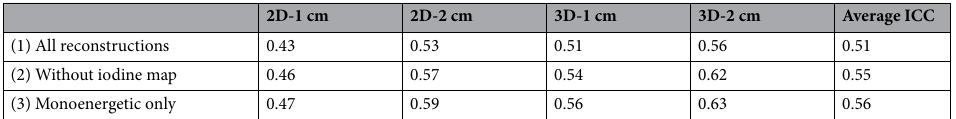
Table 2. Average ICC values for different segmentation approaches and excluding iodine map/iodine map, virtual non contrast and polyenergetic